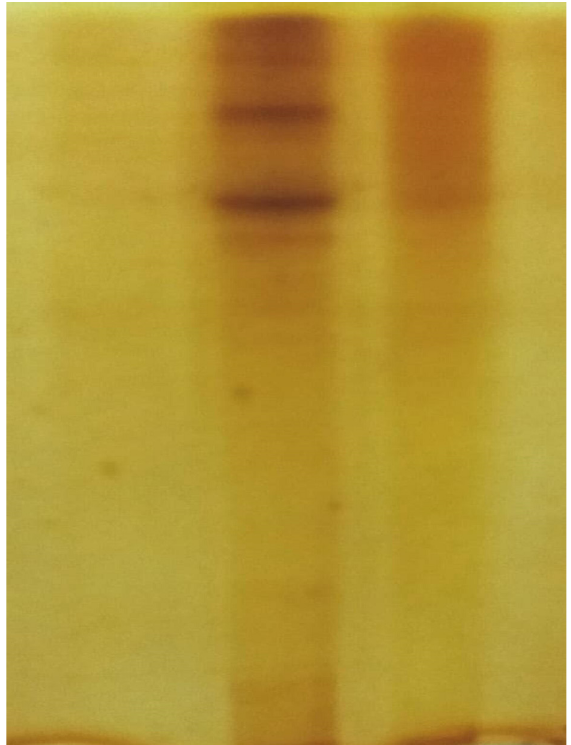
Figure 4. Electrophoresis in polyacrylamide gel stained with silver nitrate showing the protein bands of the stages of partial purification of the antimicrobial substance produced by Bacillus sp. sed 1.4. A: G-200, B: precipitated in the 0-60% range, C: crude supernatant, MW: molecular weight